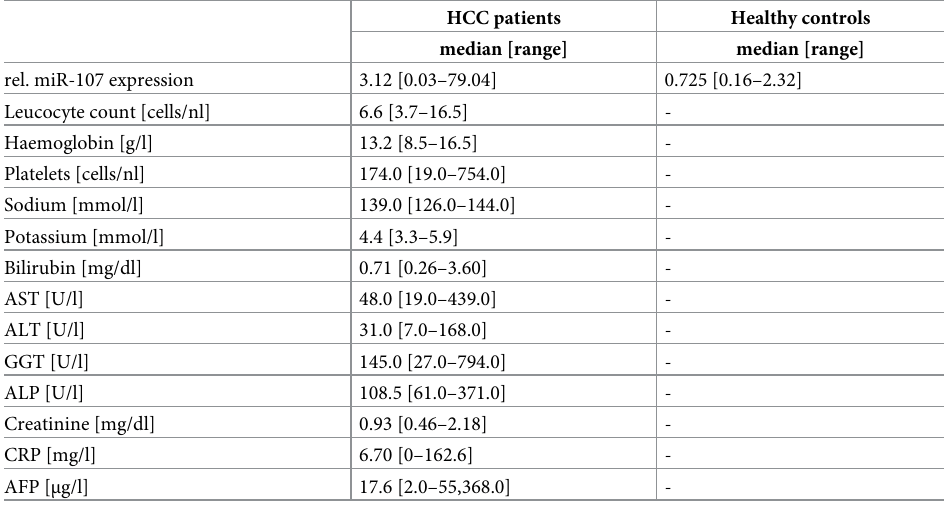
Table 2. Serum levels of various laboratory markers.